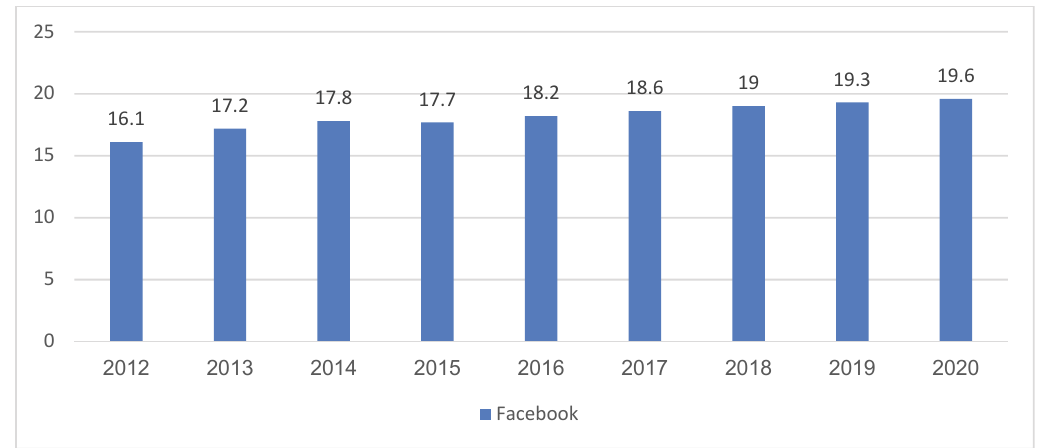
Fig. 1. The number of Facebook users (In million